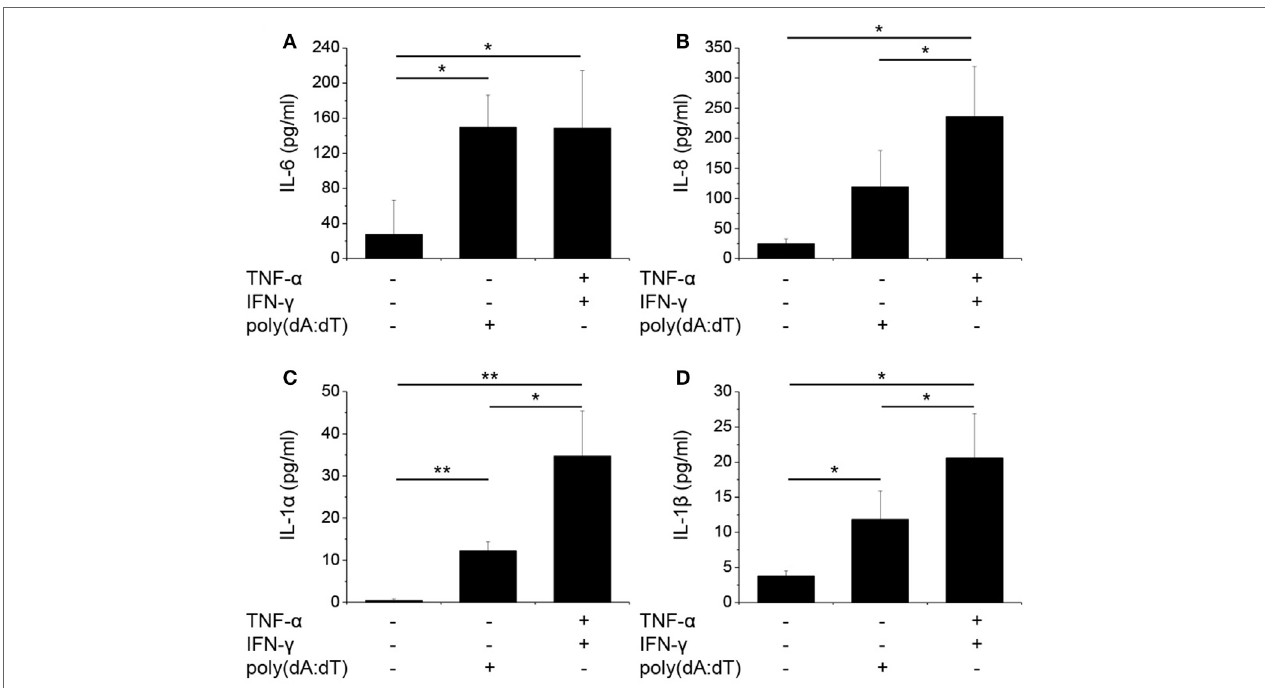
FigUre 2 | Poly(dA:dT) treatment induced the secretion of cytokines by normal human epidermal keratinocytes (NHEKs). NHEKs were transfected with poly(dA:dT) for 12 h with or without priming for 24 h with 5 ng/ml tumor necrosis factor- α (TNF- α ) and interferon- γ (IFN- γ ). Secretion of cytokines interleukin-6 (IL-6) (a) , IL-8 (B) , IL-1 α (c) , IL-1 β (D) was detected by ELISA from cell supernatant. Data are presented as mean ± SE of five independent experiments (* p ≤ 0.05; ** p ≤ 0.01; *** p ≤